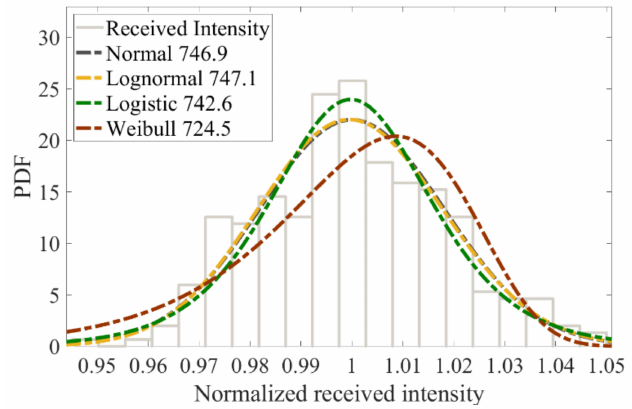
Figure 7. PDF with various fitting distributions.